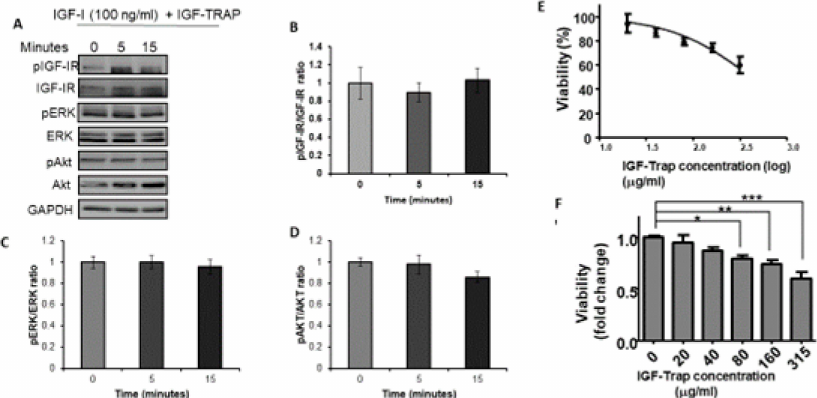
Figure 2. The IGF-Trap blocks IGF-1R signaling and inhibits the proliferation of MDA-MB-231 cells. Cells were serum starved for 24 h and then stimulated with 100 ng/mL IGF-1 in the presence of IGF-Trap added at a molar ratio of 2:1 (IGF-Trap:IGF-1) for the indicated time intervals. Shown in ( A ) is a representative Western blot of the IGF-1R and downstream signaling mediators following IGF-1 stimulation. Shown in the bar graphs ( B – D ) are the means ( ± SE) of 3 experiments expressed as pIGF-1R/IGF-1R, pERK/ERK, and pAkt/Akt ratios, respectively, normalized to the levels of unstimulated cells that were assigned a value of 1. The anti-proliferative effect of the IGF-Trap was measured by the MTT assay. Cells were treated with the indicated concentrations of the IGF-Trap in the presence of serum for 3 days. Shown in ( E , F ) are mean % ( ± SE) (top) and fold change (bottom) relative to control, vehicle-treated cells that were assigned a value of 100% and 1, respectively ( n = 3).